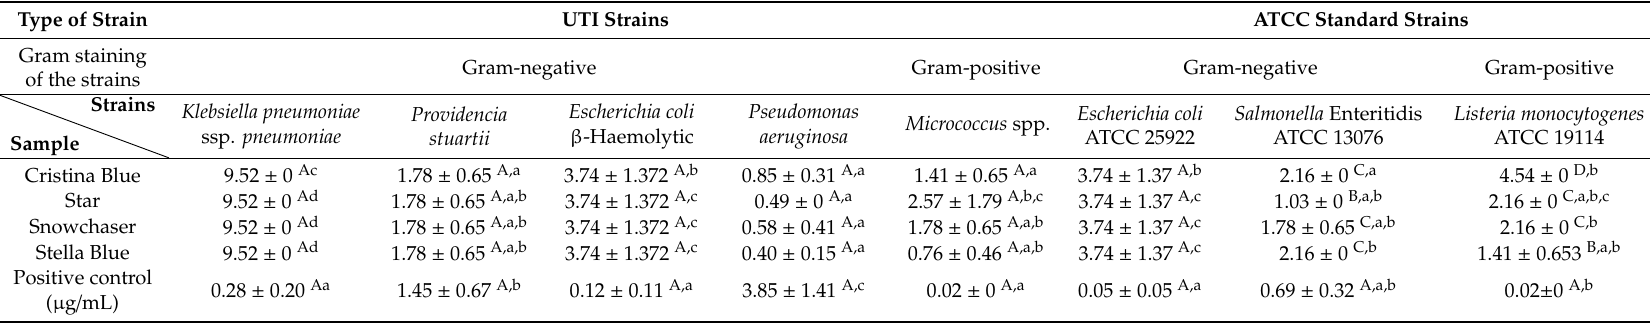
Table 4. Minimum inhibitory concentration (MIC) of anthocyanin-rich extracts from the four varieties of blueberries, expressed in mg /